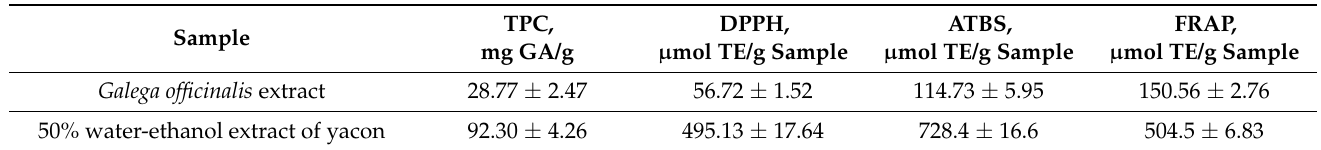
Table 2. The content of phenolic compounds and antioxidant activity of the non-alkaloid fraction of Galega officinalis extract and 50% water–ethanol extract of